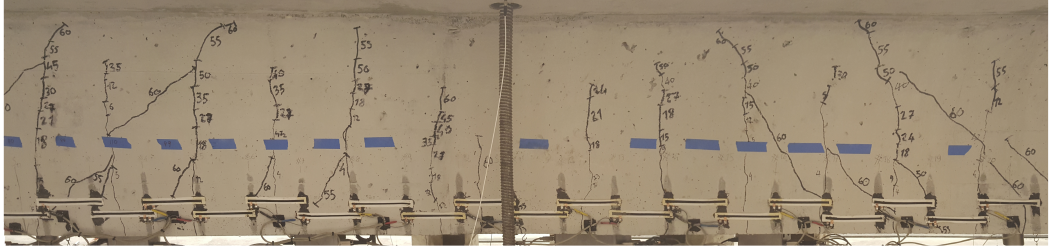
Figure 9. Picture of crack pattern before reaching ultimate strength after loading step